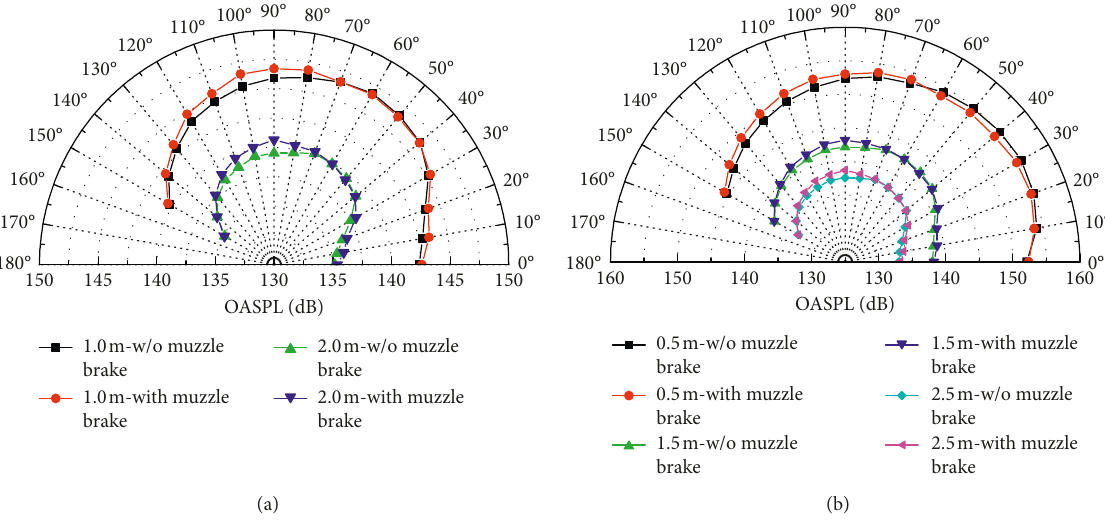
Figure 16: Noise directivity diagrams with and without the muzzle brake. (a) r � 1.0 and 2.0 m. (b) r � 0.5m, 1.5m, and 2.5